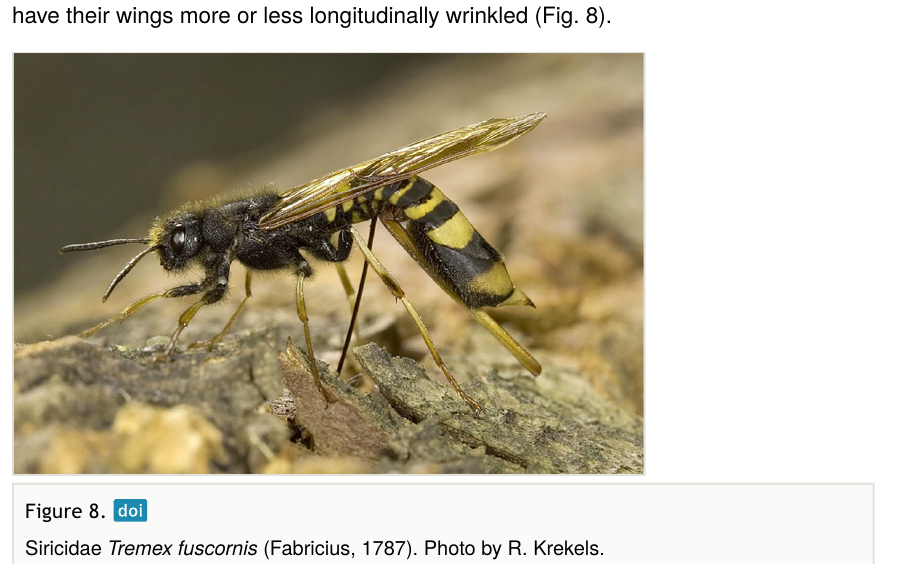
Siricidae Tremex fuscornis (Fabricius, 1787). Photo by R.